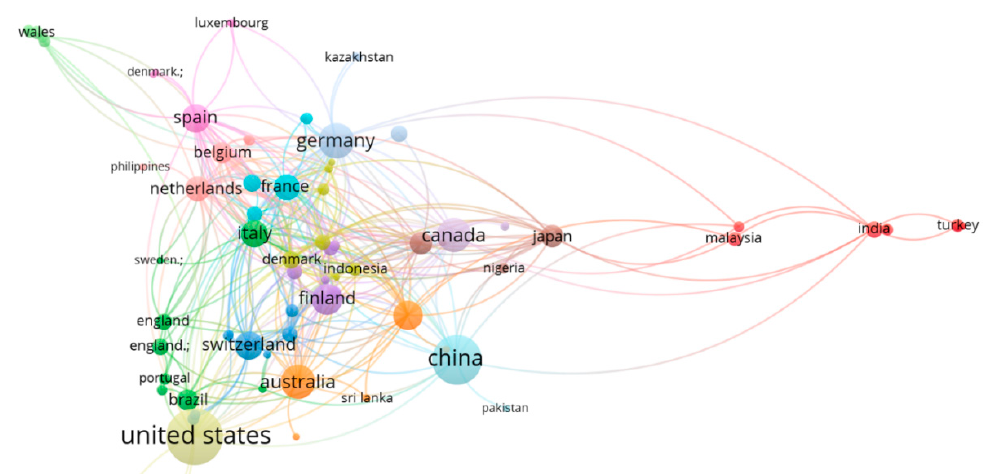
Figure 6. Network visualisation map (WoS database) of the co-authorship based on research from countries that have a minimum of one citation and one number of documents (fractional counting).